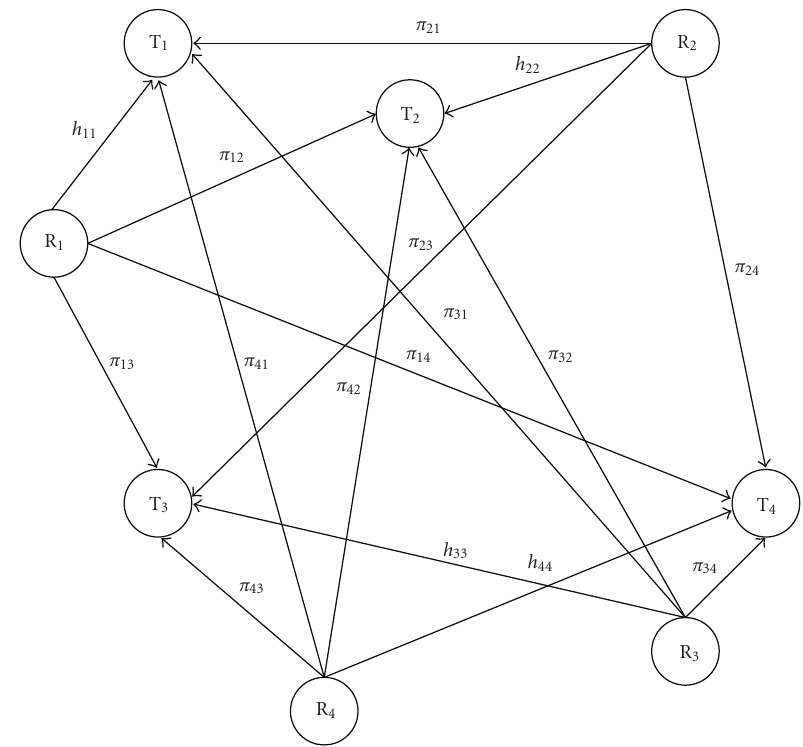
Figure 1: An example network topology with four transmitter-receiver